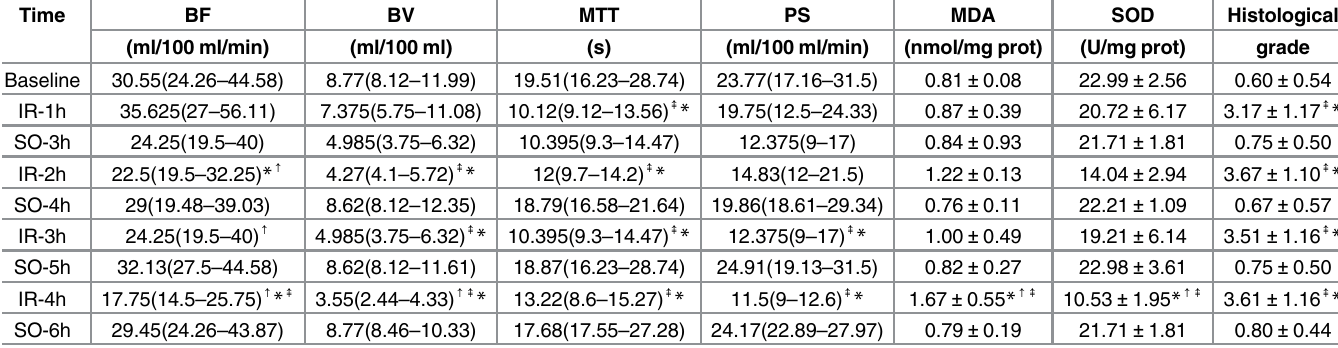
Table 1. Perfusion parameters, biochemical markers and histological grades in the different groups(median or mean ± SD). Time